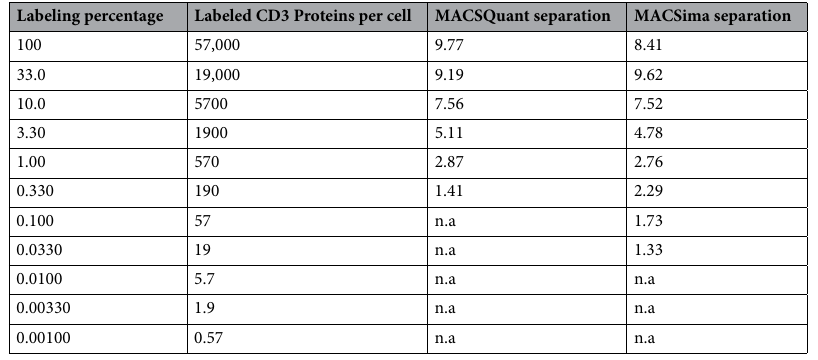
Table 1. Stoichiometric labeling percentages, average expected number of labeled CD3 proteins per cell 26 , and separation parameters, s , for the MACSQuant Analyzer and MACSima Imaging